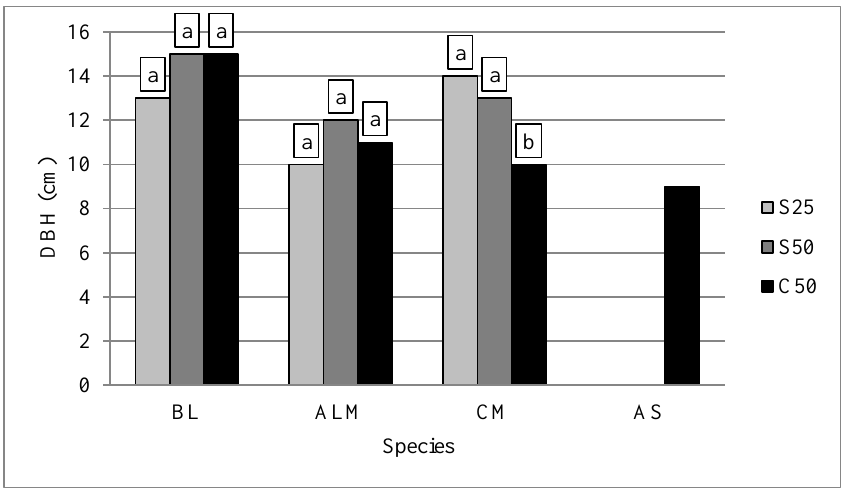
Figure 3. Median DBH of the studied tree species in individual groups of research plots. Notes: BL, ALM, CM, AS — explanations as in Figure 2, different letters indicate significant differences ( p ≤ 0.05) according to the K – W test between treatments within a species. Table 2. Statistical characteristics of the studied tree species in individual groups of research plots. Cover Name